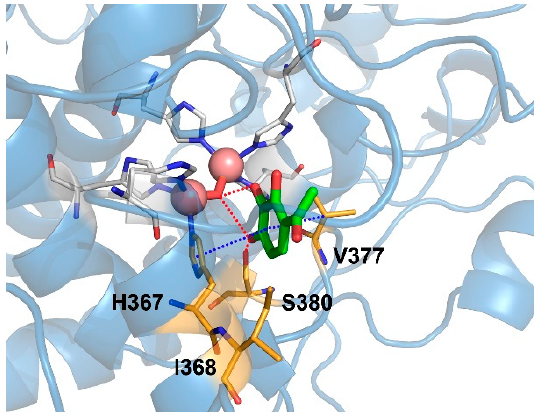
Figure 6. Proposed binding mode of gallacetophenone to the human tyrosinase model. The human tyrosinase model is represented in sky-blue color ribbons, and a water molecule (red stick) and histidine residues (white sticks) are shown chelated to copper ions (salmon spheres). The key interactions between gallacetophenone (green stick) and residues (bright orange stick) are represented as dotted blue lines ( π – π stacking and π –alkyl interactions), and red line shows hydrogen